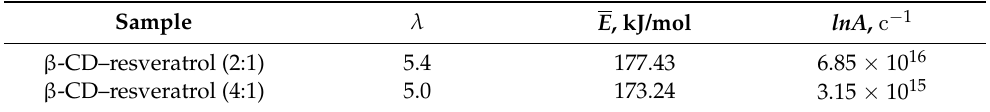
Figure 13. Surface in three-dimensional space: the dependence of the reaction rate ( β · d α /dT α ) on temperature (T) and the degree of transformation ( α ) in the air — ( а ) β -CD – resveratrol (2:1) and ( b ) β -CD – resveratrol (4:1). Table 3. Kinetic parameters of the thermal decomposition of β -CD – resveratrol (2:1, 4:1), calculated by the method of nonparametric kinetics (NPK).